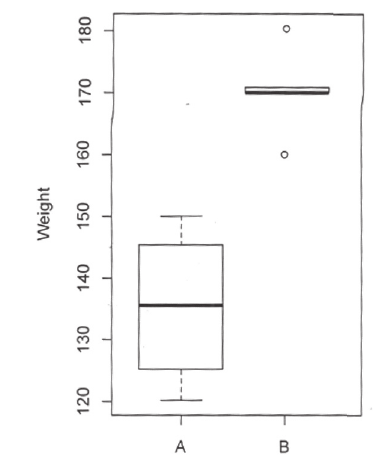
Figure 5 - Turkey Multiple Comparison of Means (Box Plot) for the final body weight shows the mean levels at 135 g and 170 g in groups A and B